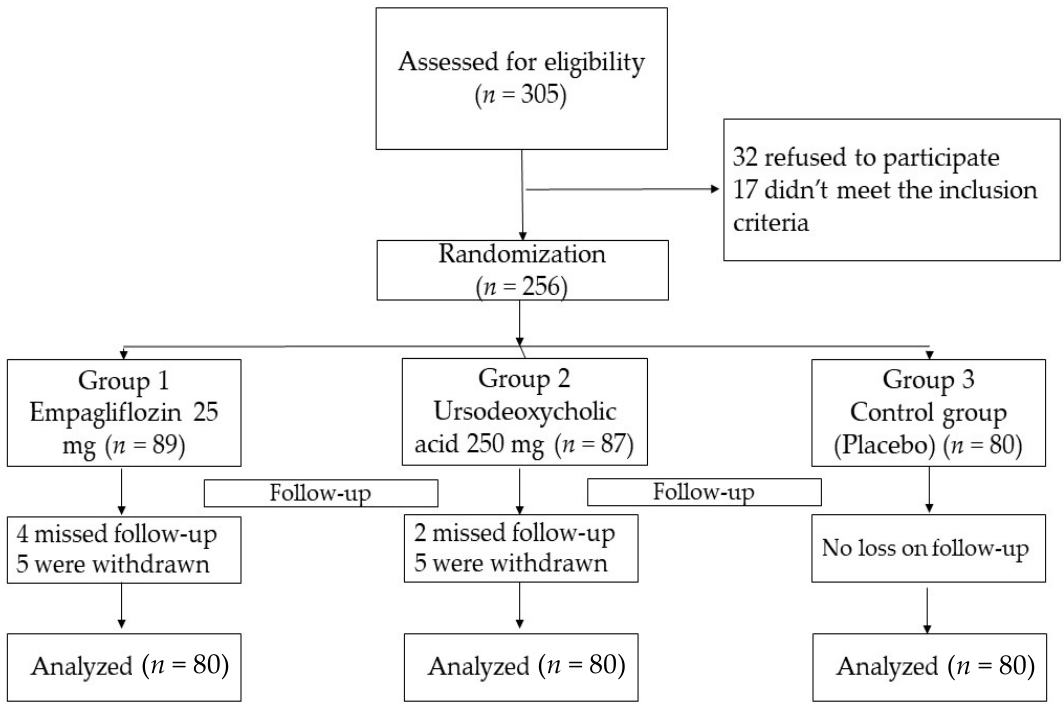
Figure 1. Flow chart of the study cohort.